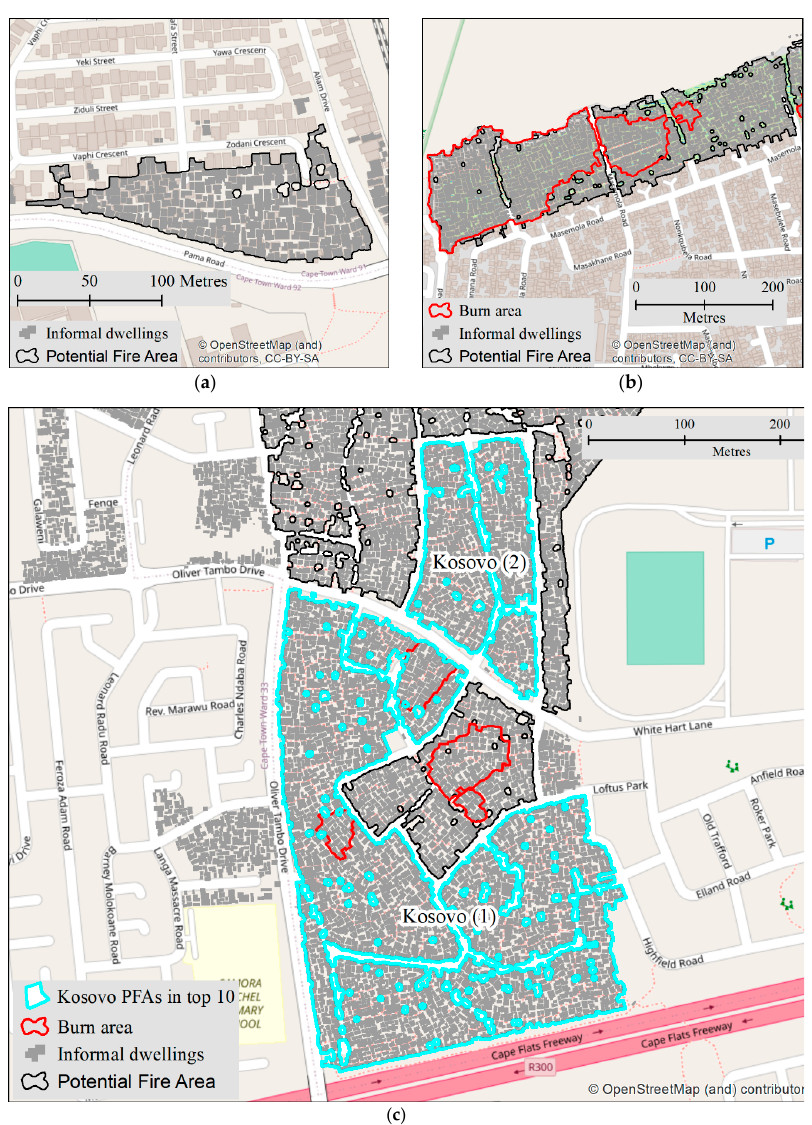
Figure 20. Selected PFAs in the top 10. ( a ) PFA with the highest fire spread rate—YAB Section; ( b ) Masiphumelele, demonstrating the fire occurrence within a PFA with a high fire spread rate; ( c ) the two PFAs in the top 10 located in Kosovo, a known informal settlement fire hot spot. Burn scars from known previous fires are indicated in red. As expected, the equation produces fire spread rates that fall within realistic ranges where the spatial metrics matched those used in the equation’s development. Since the ranges used to develop the equation fell in the high fire spread rate side of the spectrum, the PFAs highlighted as being at high risk are likely to reflect reality; also, fires mapped using satellite imagery overlap with the high fire spread rate PFAs but in the absence of a complete fire location and size database, it is impossible to use this as anything other than a qualitative agreement. Fire departments should thus be encouraged to collect accurate spatial locations (GPS coordinates) when they respond to fires as this will enable more accurate modelling, which, in turn, will inform better fire response management. Although the fire spread rate equation shows promise, this equation is not yet well enough refined to determine actual fire spread rates but rather indicates where settlements at higher risk of fire spread are located. The assumption of radial fire spread in the modelling has been mentioned and the shape of the settlements is likely to have an impact on the rate of fire spread with elongated settlement representing less of a fire spread risk than more compact settlements. Additionally, it should be considered to assign weight values to different settlement sizes, since large settlements have the potential to become larger conflagrations. Finally, it is unknown how well the model performed for settlements with spatial metrics outside the range of those used to develop Equation (11). Finally, B-RISK currently only allows for rectangular-shaped dwellings and the reality of what